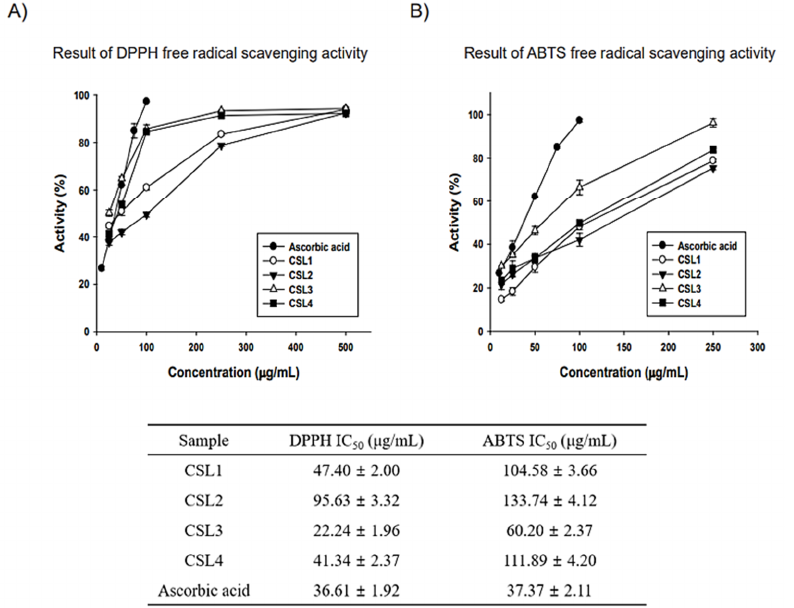
Figure 2. Antioxidative efficacy measurements of CSL extracts. ( A , B ) Antioxidant activity results: 2,2-diphenyl-1-picrylhydrazyl (DPPH) and 2,2-azino-bis (3-ethylbenzthiazoline-6-sulfonic acid)